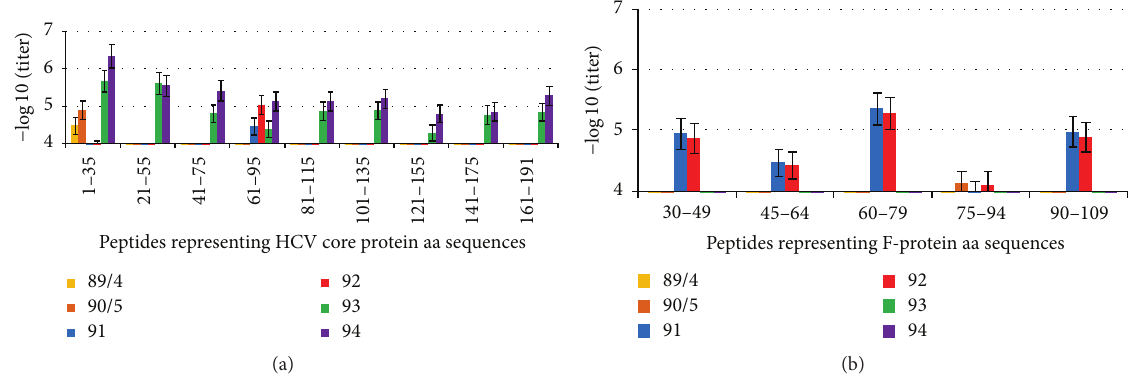
Figure 3: Fine epitope mapping of antibody response to linear epitopes of HCV core (a) and F-protein (b) recognized by rabbits immunized with HCV core aa 1–173 (nn 93, 94), HCV core 1–152 (89/4, 90/5), and F-protein (91, 92). Graphs demonstrate the highest antibody titers reached throughout immunization and represent the result of two to three independent ELISA runs. Unspecific antipeptide reactivity in control rabbits receiving adjuvant alone was below 5 × 10 2 .